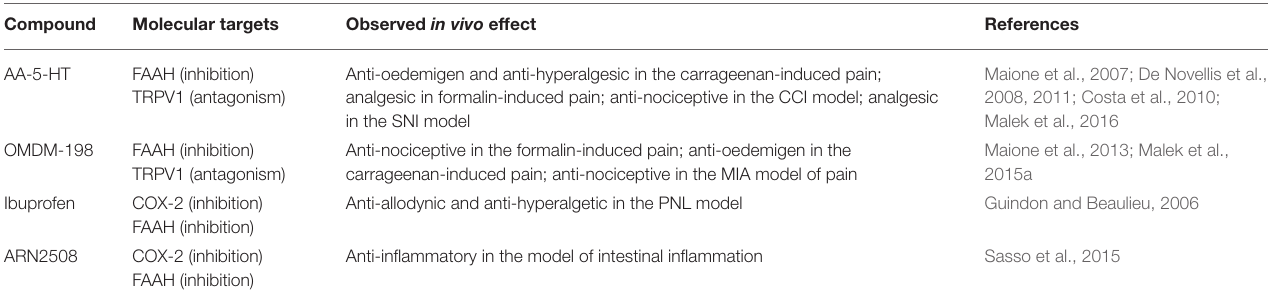
TABLE 1 | Dual-acting compounds: summary of in vivo studies.